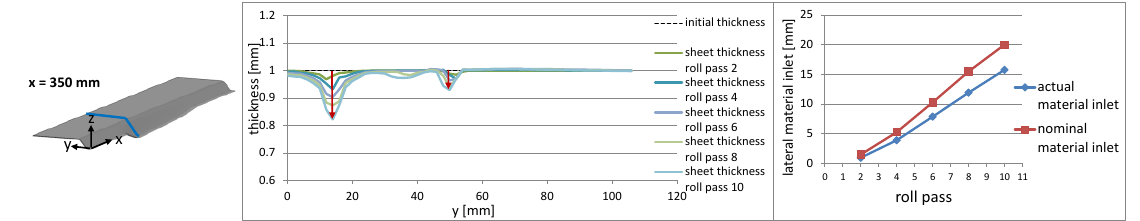
Figure 21. Correlation between material thinning and insufficient lateral material inlet.